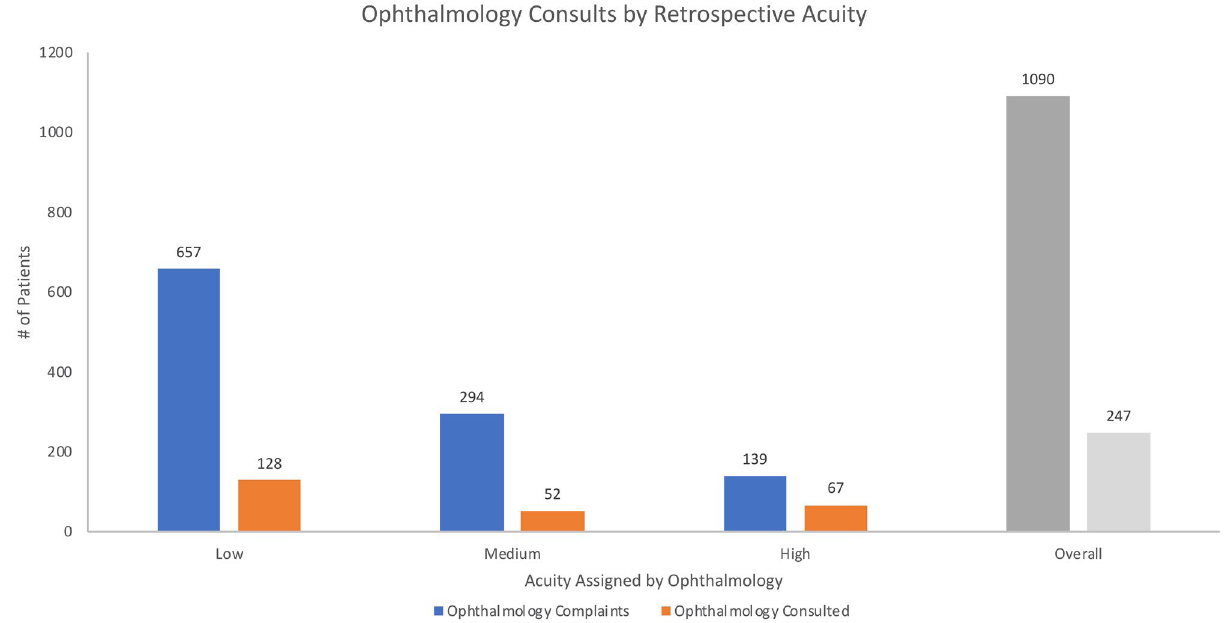
Figure 1. Breakdown of ophthalmology complaints and consults by retrospectively-assigned ophthalmologic